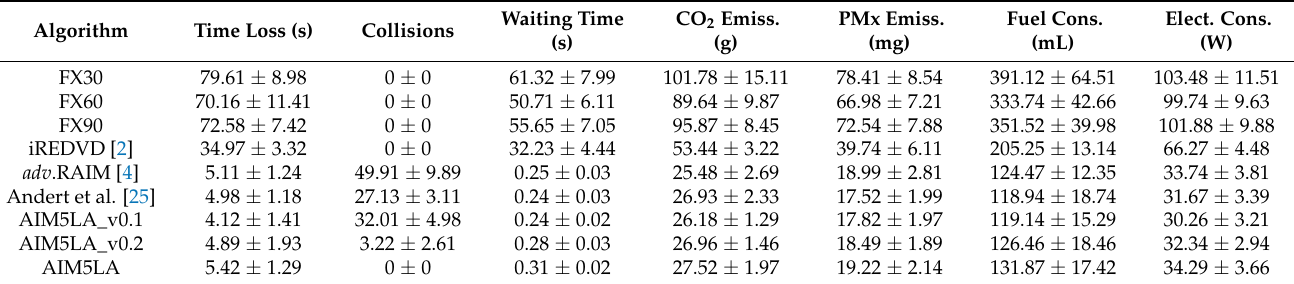
Table 4. Results of testing